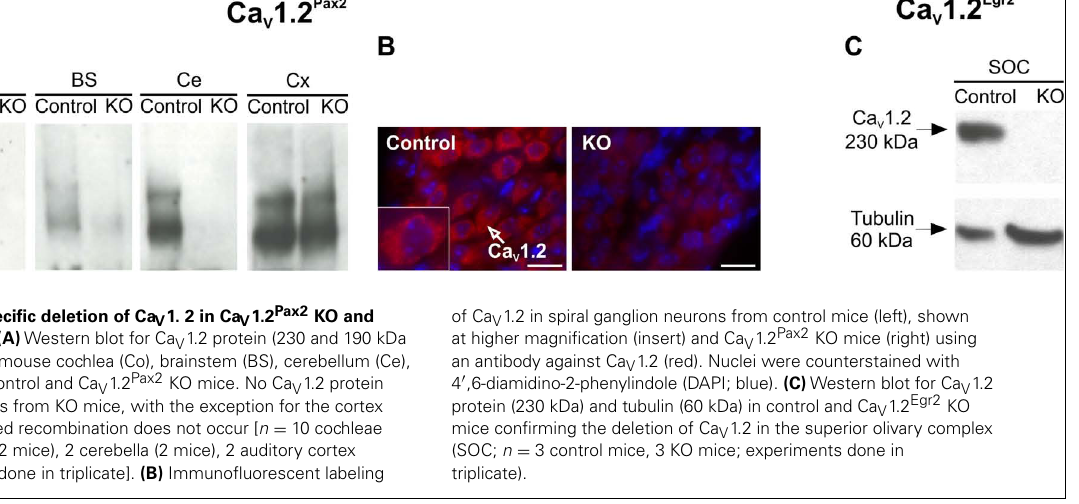
of Ca V 1.2 in spiral ganglion neurons from control mice (left), shown at higher magnification (insert) and Ca V 1.2 Pax2 KO mice (right) using an antibody against Ca V 1.2 (red). Nuclei were counterstained with 4 (cid:2) ,6-diamidino-2-phenylindole (DAPI; blue). (C) Western blot for Ca V 1.2 protein (230 kDa) and tubulin (60 kDa) in control and Ca V 1.2 Egr2 KO mice confirming the deletion of Ca V 1.2 in the superior olivary complex (SOC; n = 3 control mice, 3 KO mice; experiments done in